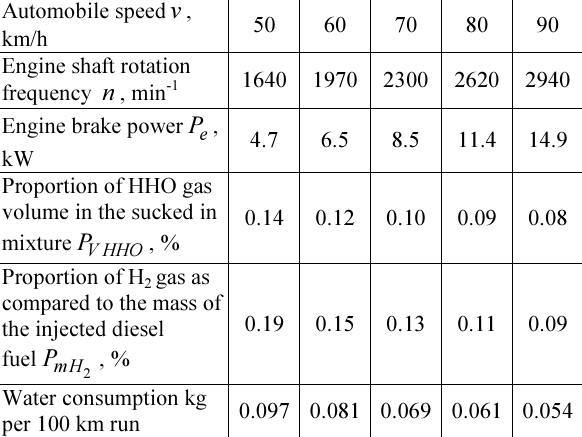
Table 2. Engine operational characteristics of an automobile driving at various